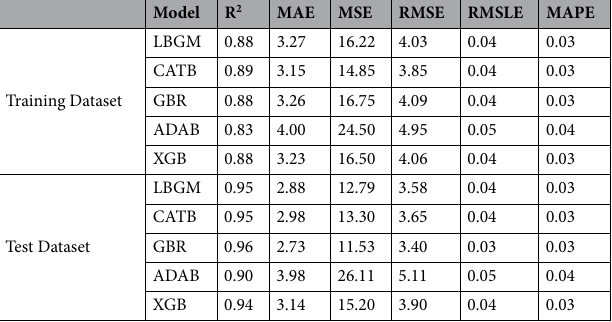
Table 5. Summary of RS optimised models.